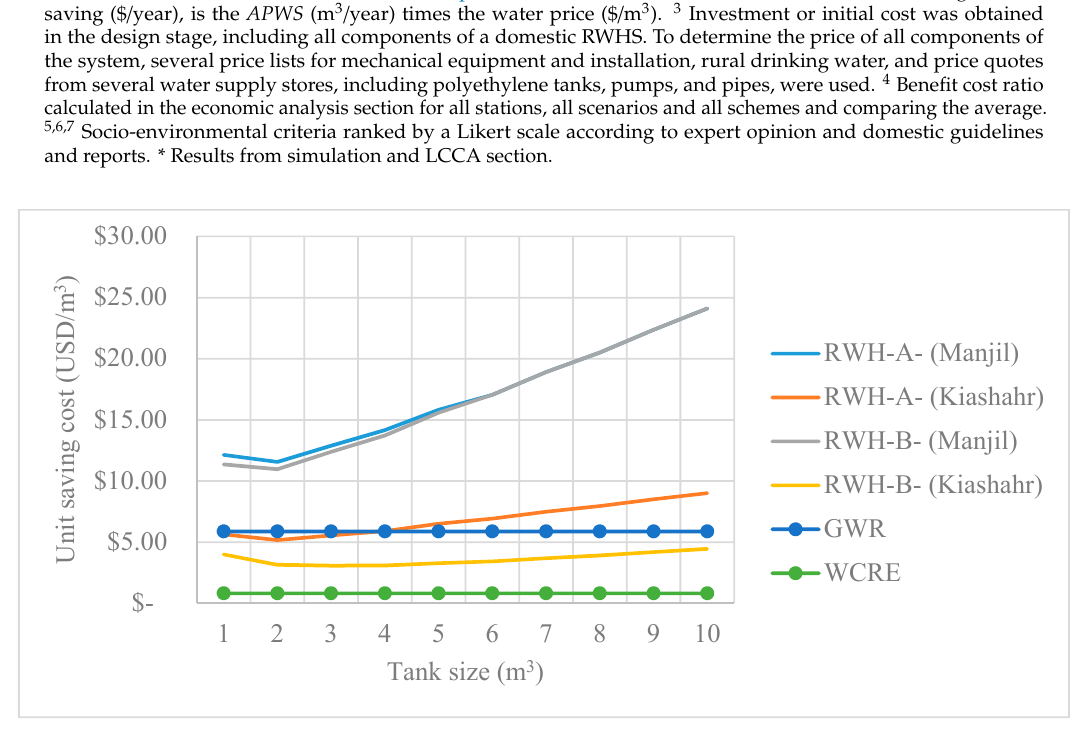
Figure 8. Comparison of APWS in scenarios A and B of tank size 3 m 3 and the generalized method.